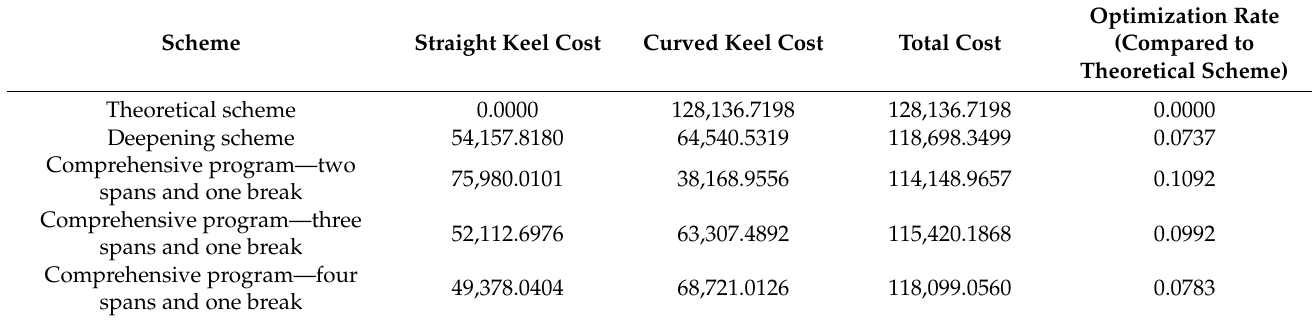
Table 15. The total keel cost for the three